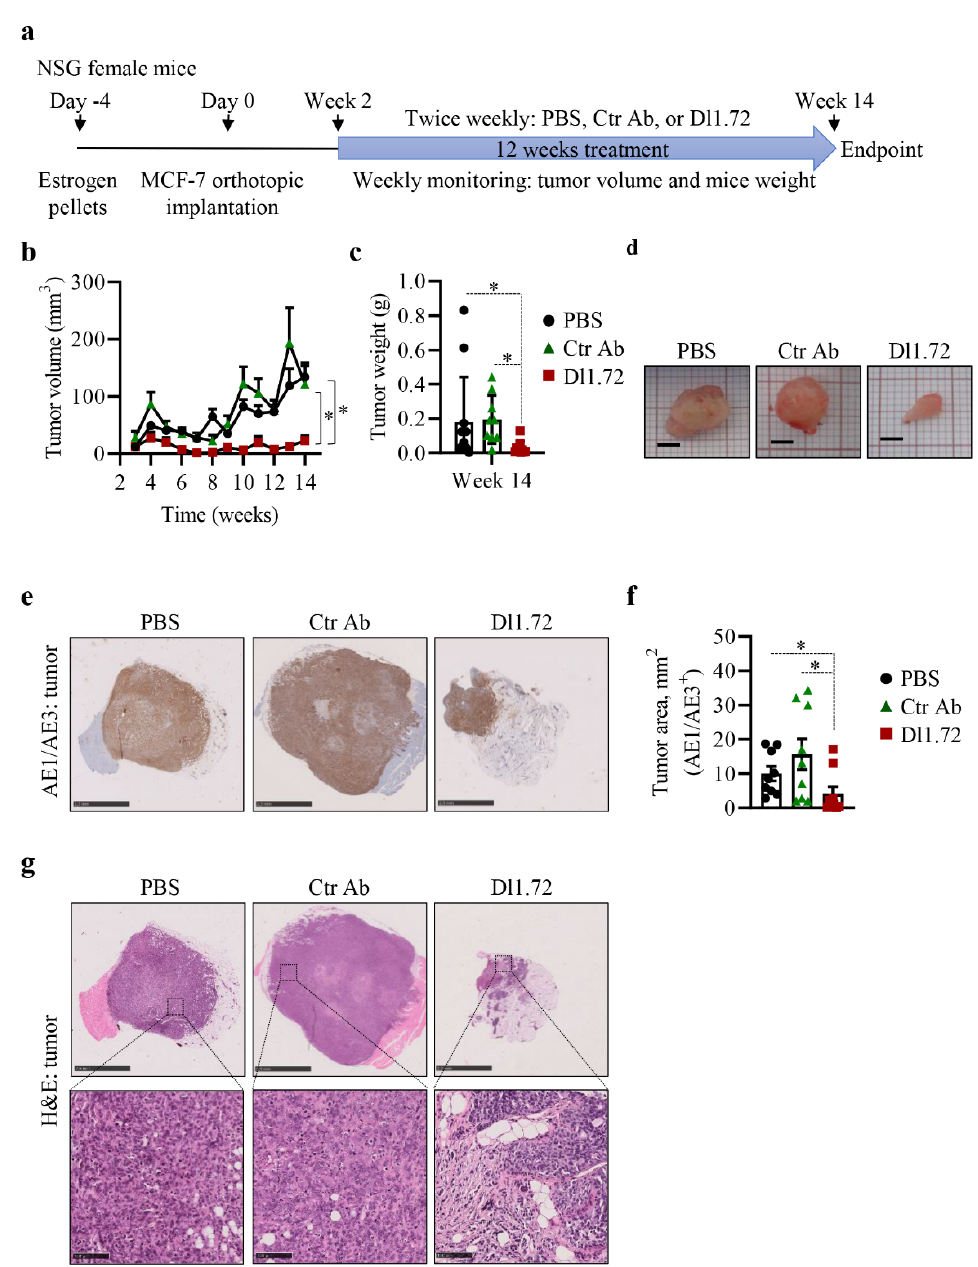
Figure 5. Anti-DLL1 Dl1.72 decreases tumor growth in a MCF-7 xenograft mice model. ( a ) Schematic representation of mice tumor induction and treatment with either PBS (control vehicle) or with 10 mg per kg of isotype-matched Ctr Ab or Dl1.72 for 12 weeks. ( b ) Tumor growth was evaluated by caliper (PBS, n = 12; Ctr Ab, n = 9; Dl1.72, n = 10). ( c ) Weight of tumors from each group immediately after resection. ( d ) Representative whole tumor images from each group. ( e ) Representative IHC images of the largest cross-sections of tumors from each group stained with the pan-cytokeratin AE1/AE3 Ab, specific to human epithelial cells. Scale bars, 2.5 mm. ( f ) Quantification of tumor area determined by AE1/AE3 staining ( n = 9 tumors/group). ( g ) Representative hematoxylin and eosin (H&E) stained images of tumor cross-sections of each group. Scale bars, 2.5 mm (top image) and 100 µm (bottom image). Data are expressed as mean values ± SEM. *, p < 0.05 by one-way ANOVA with Tukey’s multiple comparisons test in ( a ) and the Mann–Whitney test in ( c , f